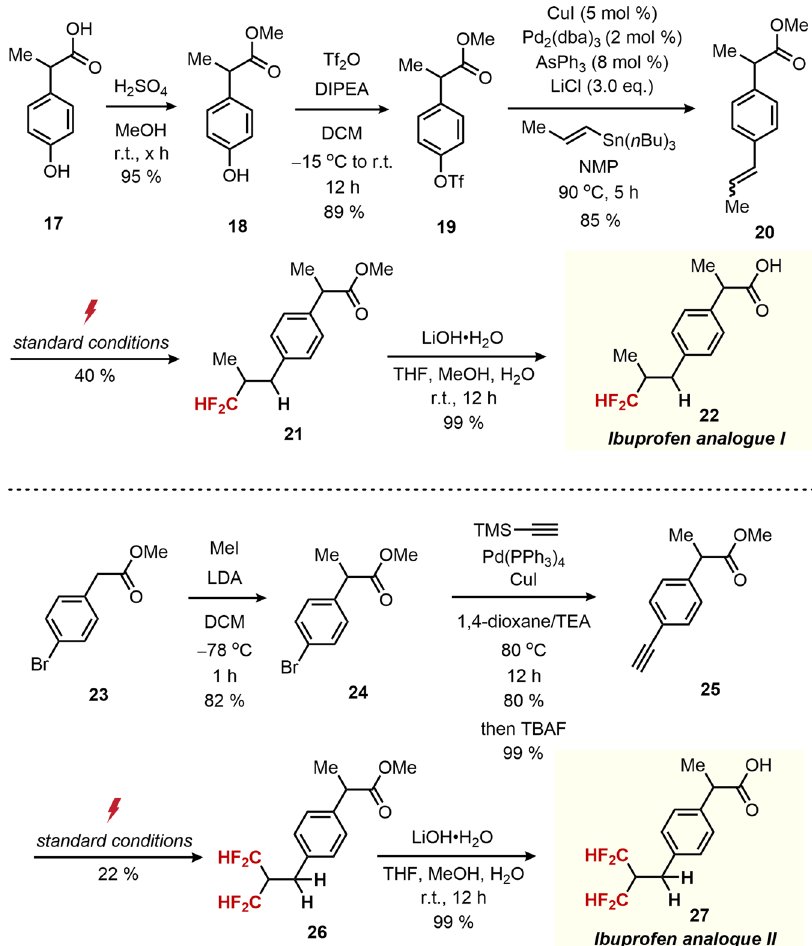
Fig. 8 Synthesis of CF 2 H analogues of ibuprofen. The requisite starting material 20 was prepared in three steps from 2-(4-hydroxyphenyl)propanoic acid (17). The desired hydrodi fl uoromethylation was proceeded under the standard conditions (21). Hydrolysis of 21 led to the formation of di fl uoromethyl analogue of Ibuprofen (22) in 28% overall yield (5 steps). The developed double hydrodi fl uoromethylation protocol allowed conversion of alkyne 25 into corresponding geminal bis-di fl uoromethylation product 26. Upon treatment of 26 with base under aqueous conditions, a bis-di fl uoromethyl analogue of Ibuprofen (27) was Methods General procedure for electroreductive hydrodi fl uoromethylation of vinylar- enes . An oven-dried, 10mL two-neck glass tube was equipped with a magnetic stir bar, a rubber septum, a threaded Te fl on cap fi tted with electrical feed-throughs, a carbon felt anode (1.0 ×0.5 cm 2 ) (connected to the electrical feedthrough via a 9cm in length, 2mm in diameter graphite rod), and a zinc plate anode (1× 0.5 ×0.02 cm 3 ). To this reaction vessel, LiClO 4 (85.1 mg, 0.8mmol) was added.